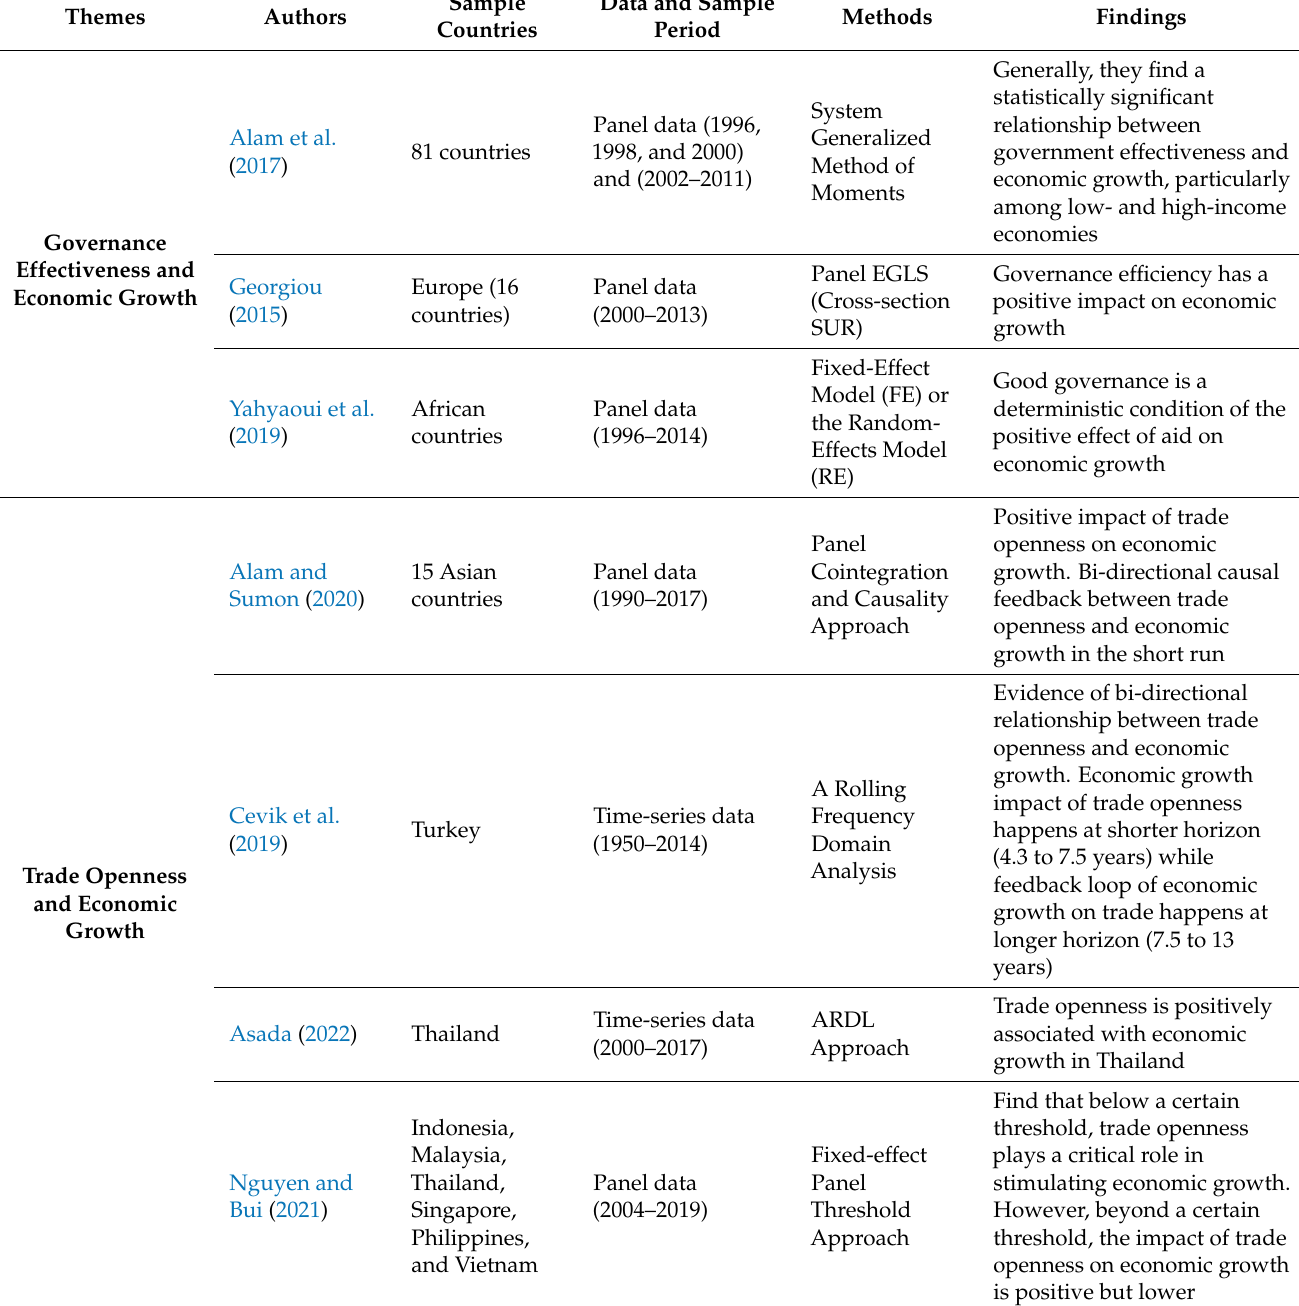
Table A3. Findings of the reviewed